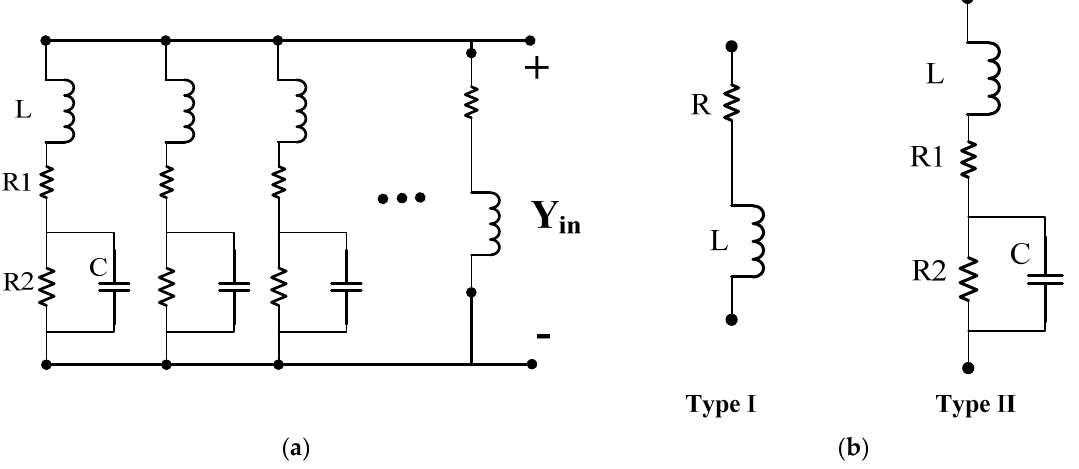
Figure 9. Forms of circuit model for admittance: ( a ) entire circuit model; ( b ) basic sub-circuit model.